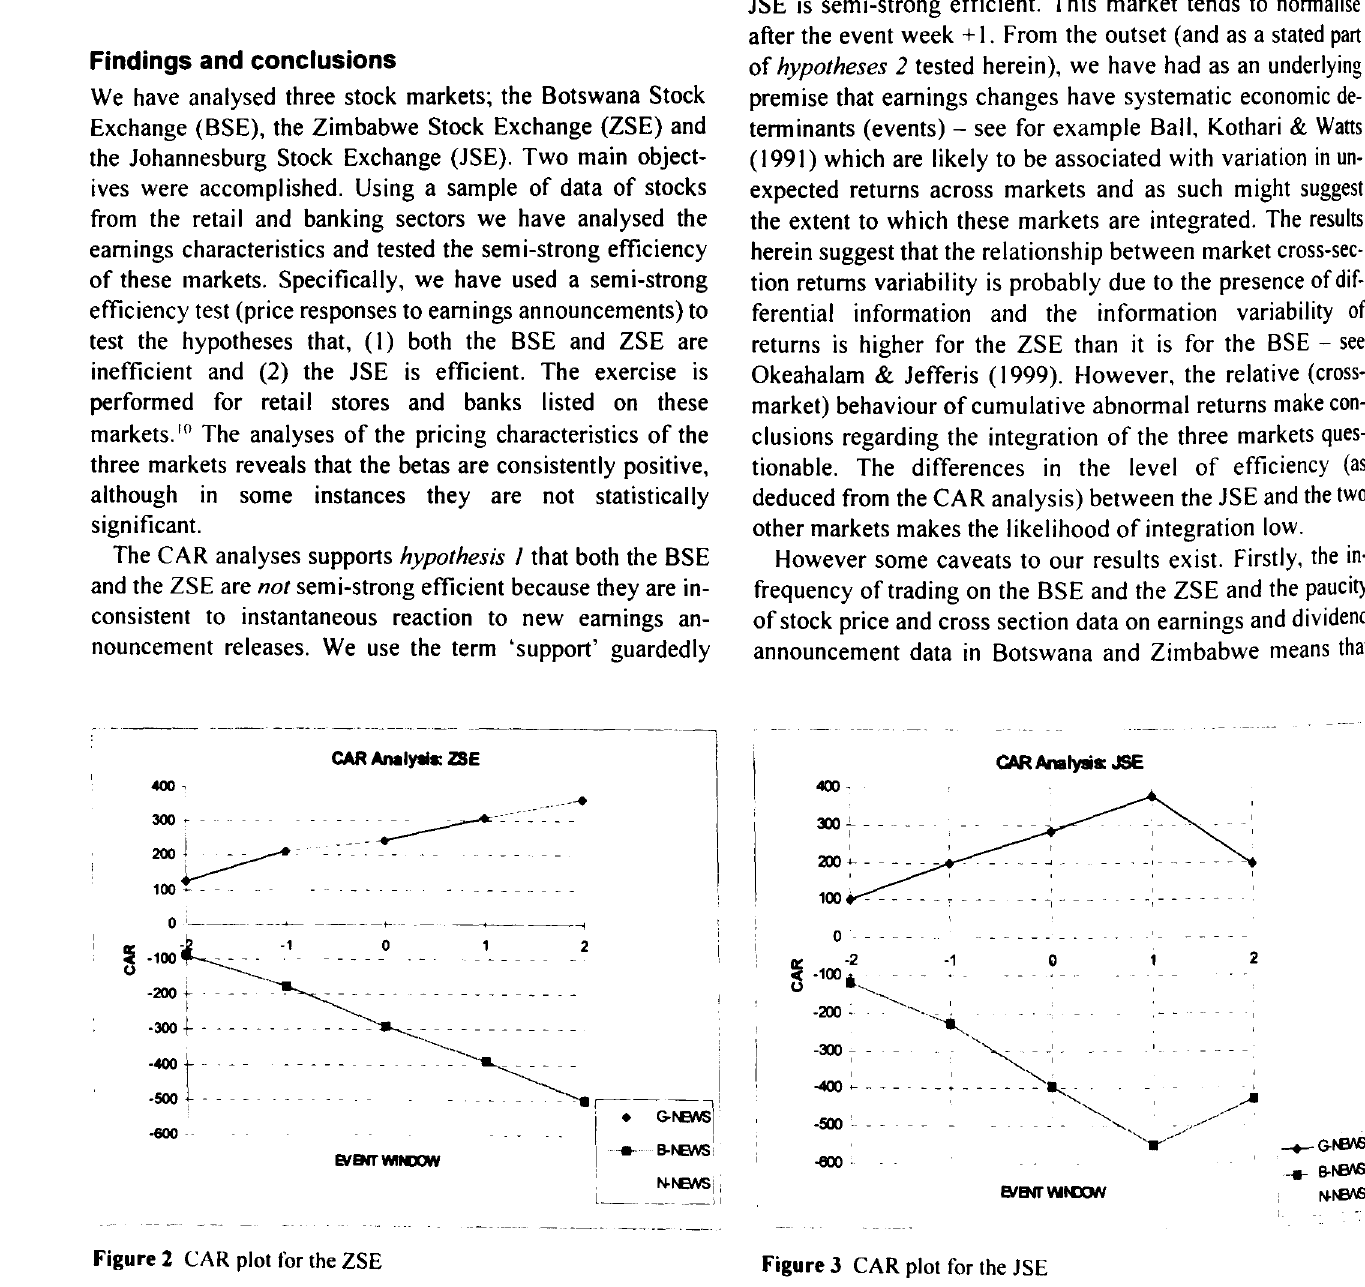
Figure 2 CAR plot for the ZSE Figure 3 CAR plot for the